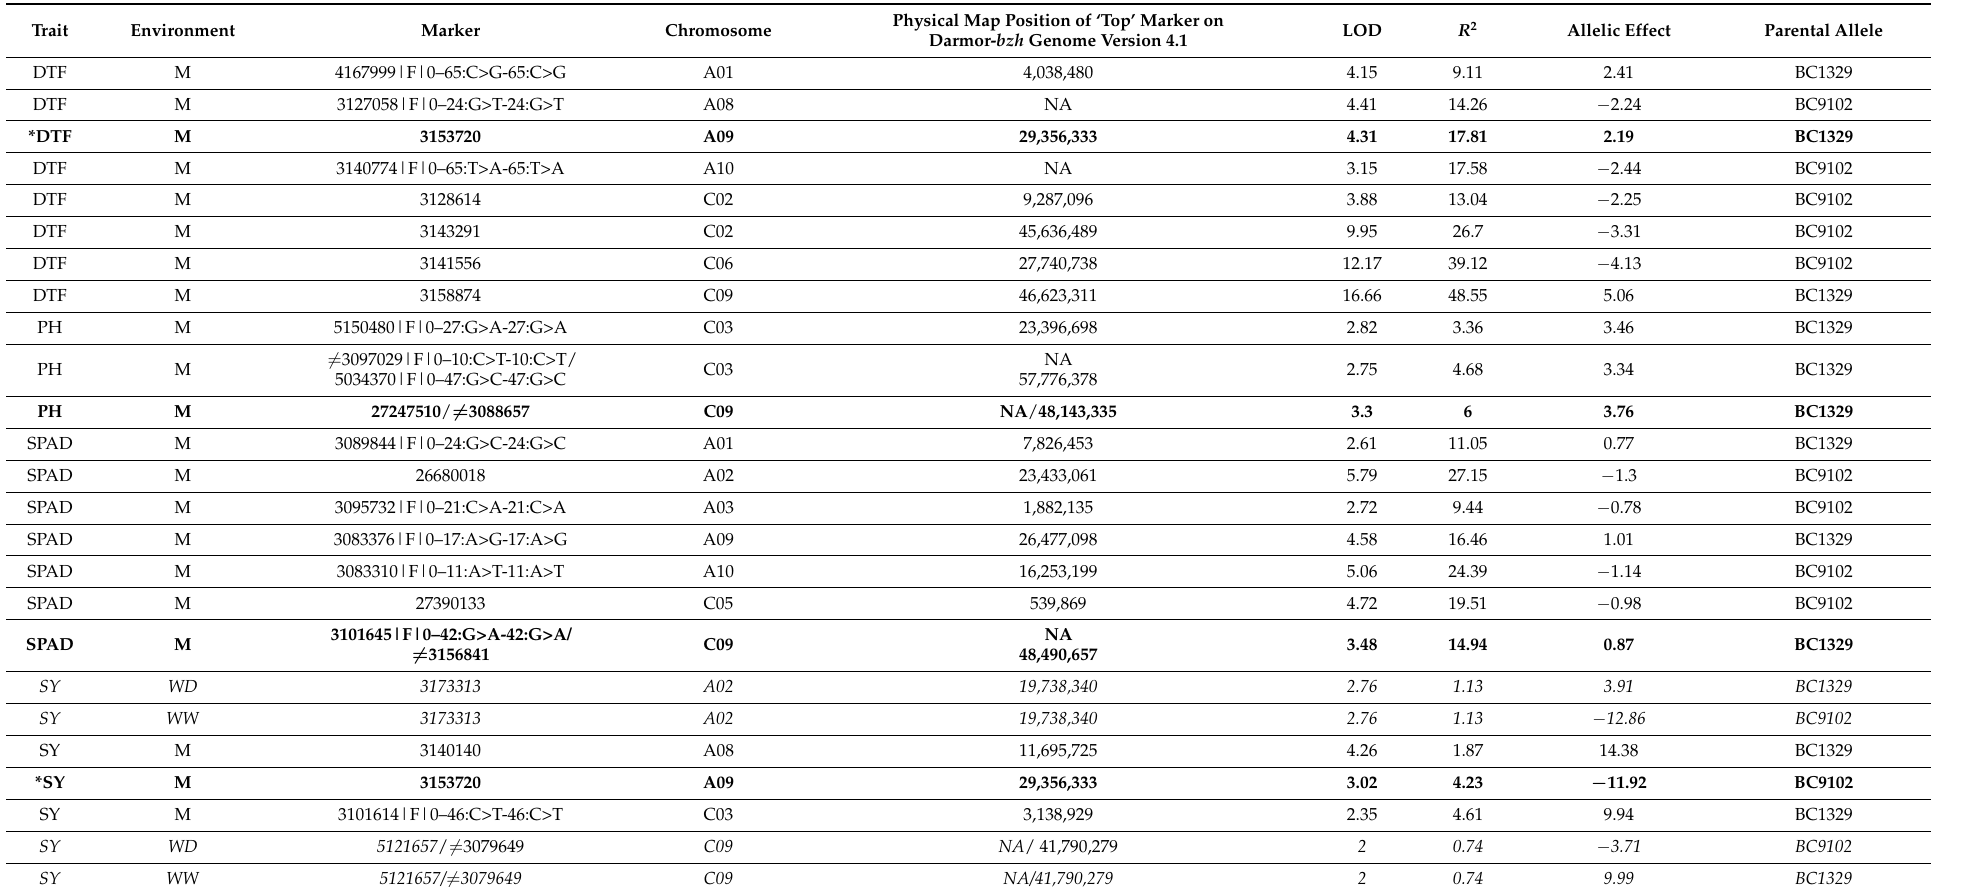
Table 4. Markers associated with the QTL main effects and QTL by Environment (watering block) interaction for seed yield (SY) and other agronomic traits (DTF: Days to flower; PH: Plant height; SPAD: Chlorophyll content) using a doubled haploid population derived from BC1329/BC9102, in well-watered and water-deficit conditions under a rainout shelter (M: main effect; WW: well-watered block; WD: water-deficit block). The LOD scores ( − log 10 p -value), allelic effect, parental allele and percentage of genetic variance explained ( R 2 ) are also provided. The QTL by Environment interactions for each environment are in italics. Consistent markers that were associated with multiple traits are in bold font. The * QTL for corresponding traits were detected under field trials and a pot trial in rainout shelter conditions [15]; (cid:54) = Marker positions are approximate, as the DArTseq did not return significant hits for desired linkage group. NA: Unknown (marker sequence could not be mapped onto the reference